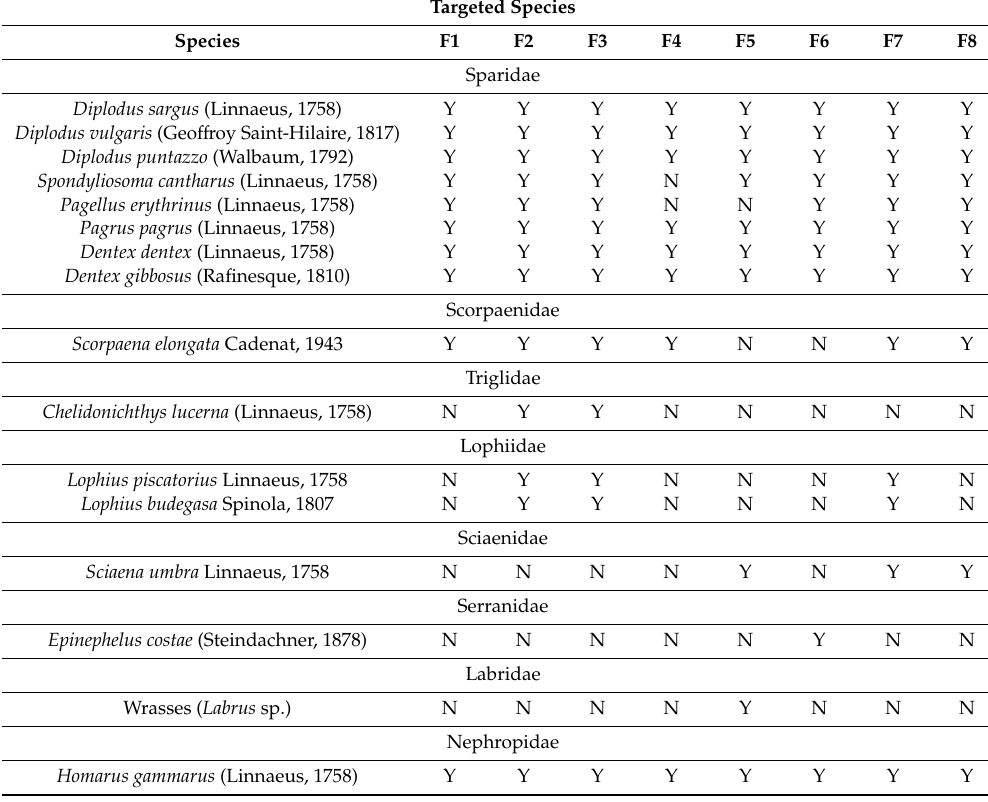
Table 3. Targeted species associated with the spiny lobster fishery along the Chalkidiki Peninsula based on interviews and